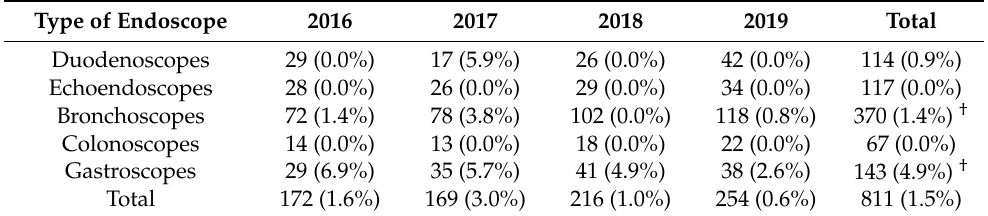
Table 2. Number of microbiological samplings and level of contamination (%) of the disinfected endoscopes.